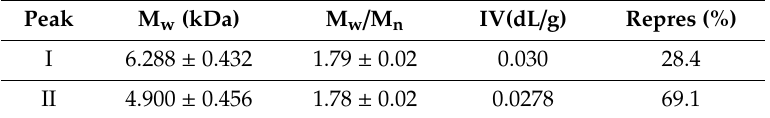
Table 1. Weight average molar mass (M w ), polydispersity index (M w / M n ), intrinsic viscosity (IV), and representatives are shown. The analyses were performed at least in duplicate.